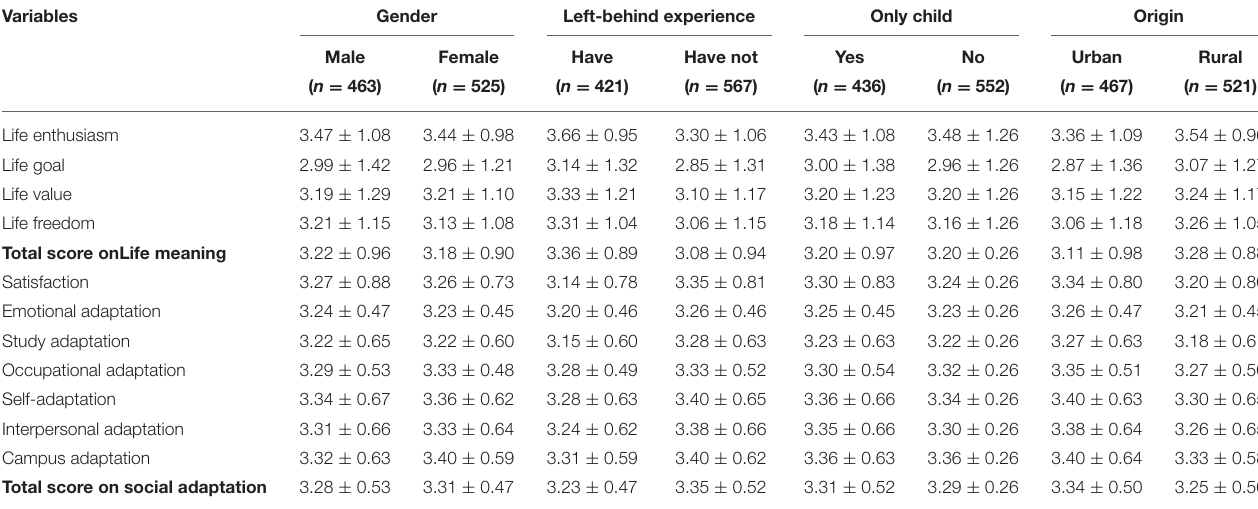
TABLE 2 | Descriptive statistics of MLS and SAS scores among undergraduates. Variables